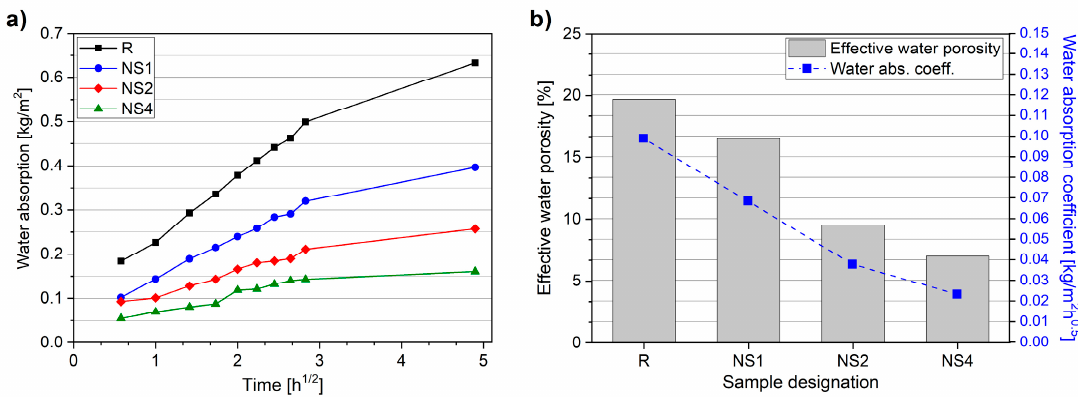
Figure 8. Capillary absorption curve ( a ), effective water porosity and water absorption coefficient ( b ).